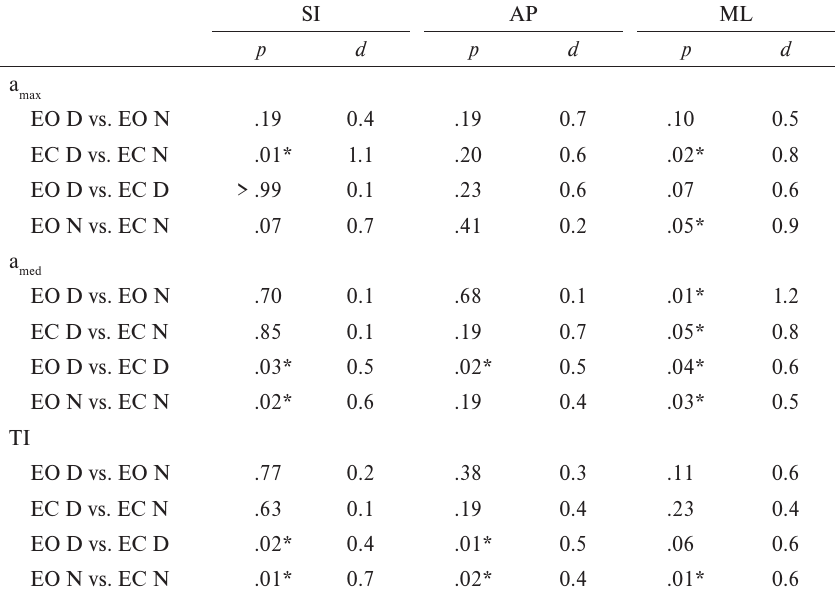
The calculated p-values from the Wilcoxon test and Cohen’s d to assess the differences between the results of measurements of dominant and non-dominant arm, and mea- surements with EO and EC